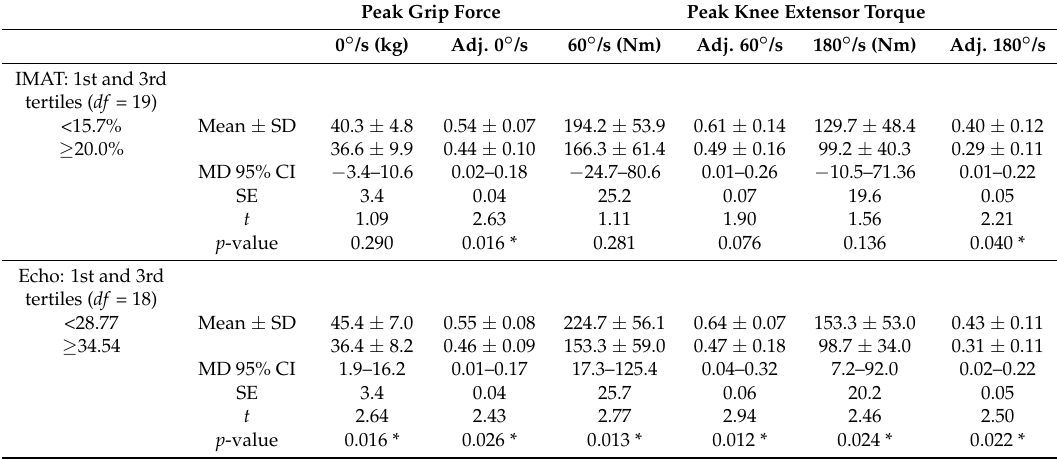
Table 5. Differences in muscle strength based on the first and third tertiles of rectus femoris echogenicity and mid-thigh intra- and intermuscular adipose tissue